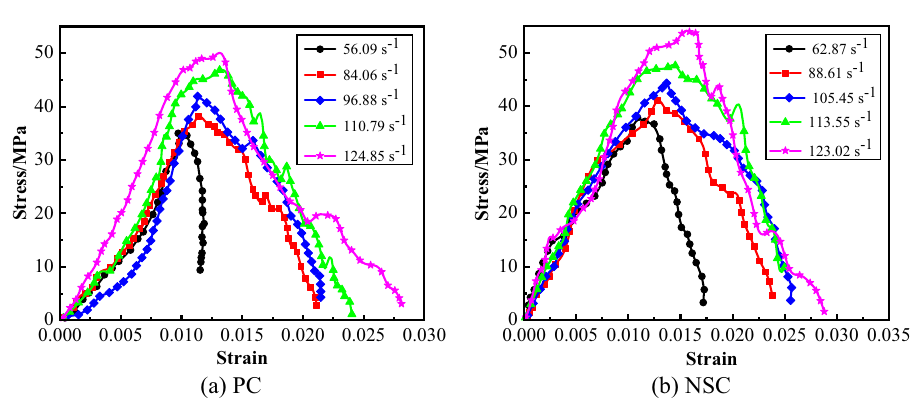
Figure 11. Stress–strain curves of concretes under dynamic